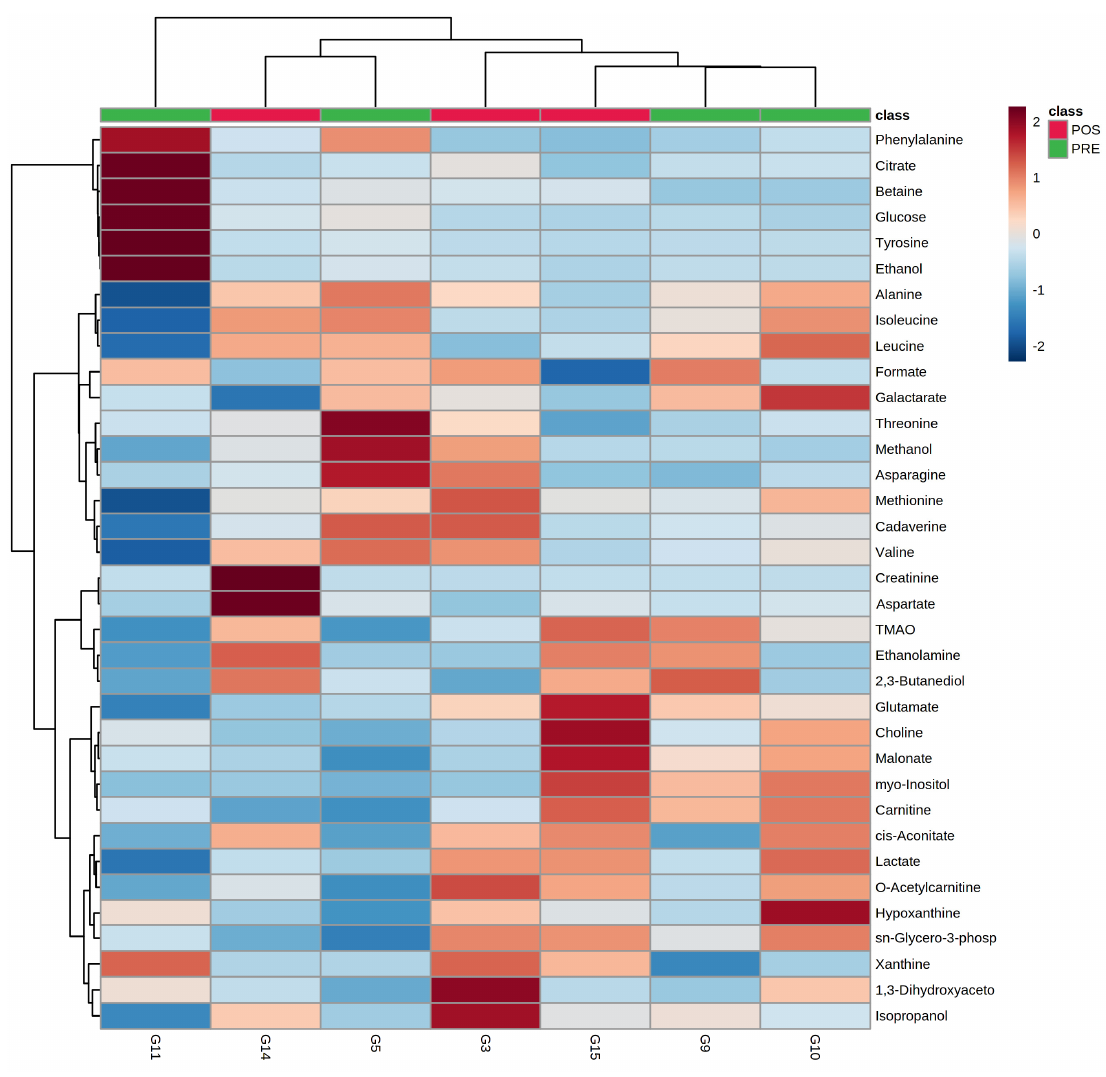
Figure 6. Volcano plot based on the comparisons between the concentrations of molecules in giant panda seminal plasma from the PRE and POST estrus groups. The right upper part shows the comparison for isopropanol.